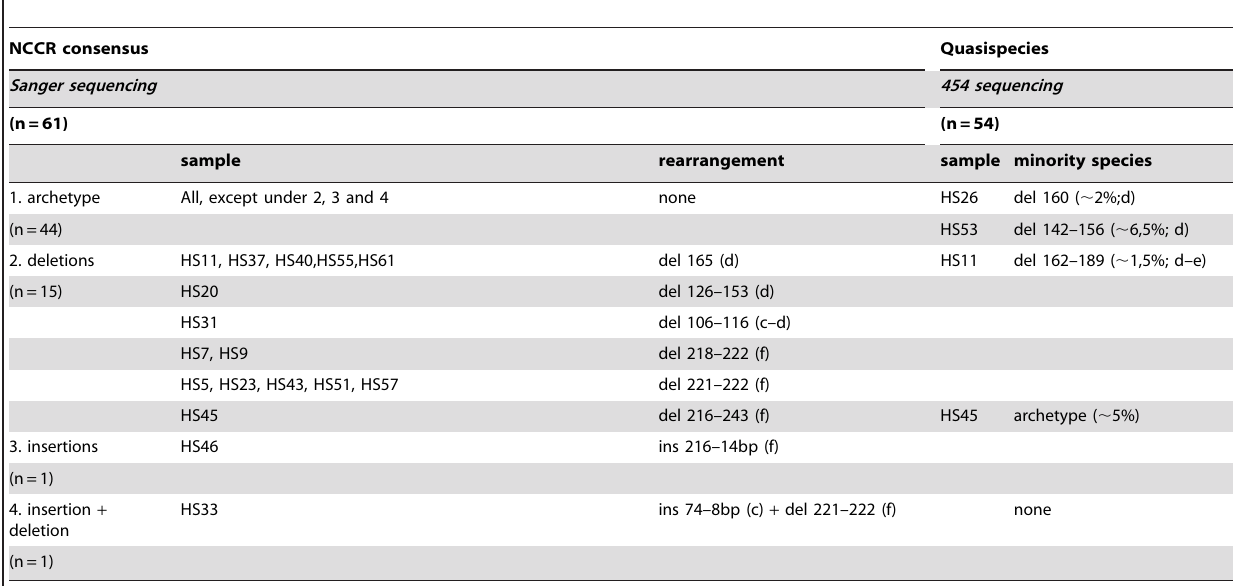
Table 1. Overview of JC virus NCCR rearrangements ( i.e. deletions and insertions) identified by Sanger sequencing and 454